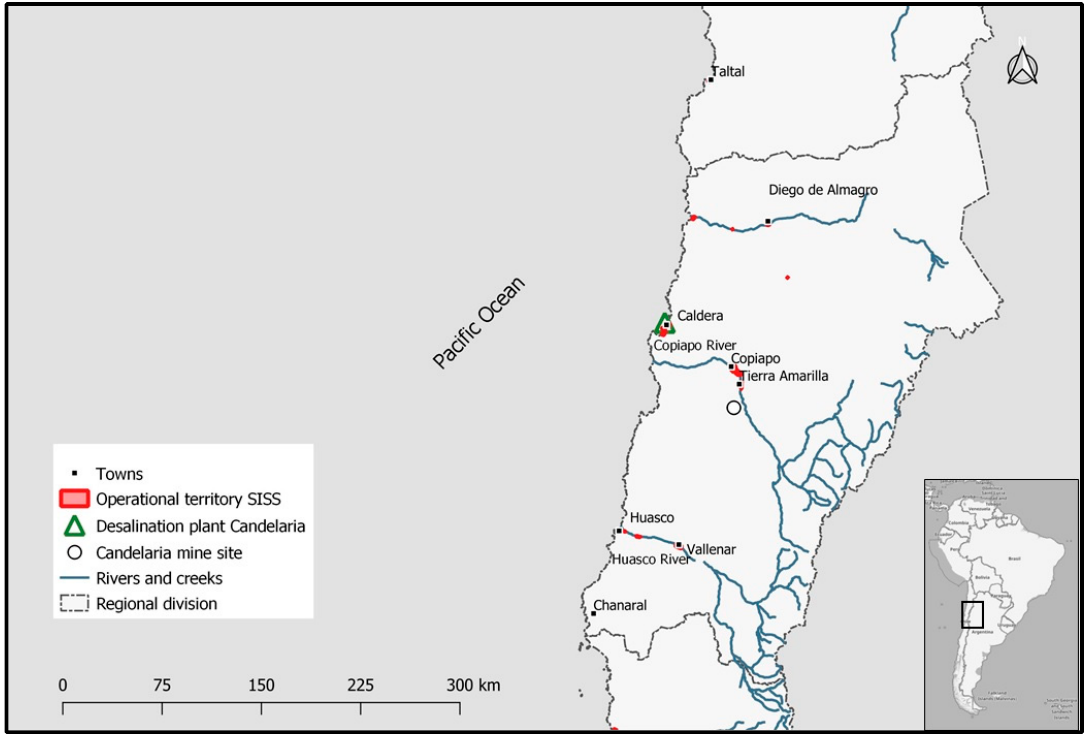
Figure 2. Desalination plant operated by Candelaria.